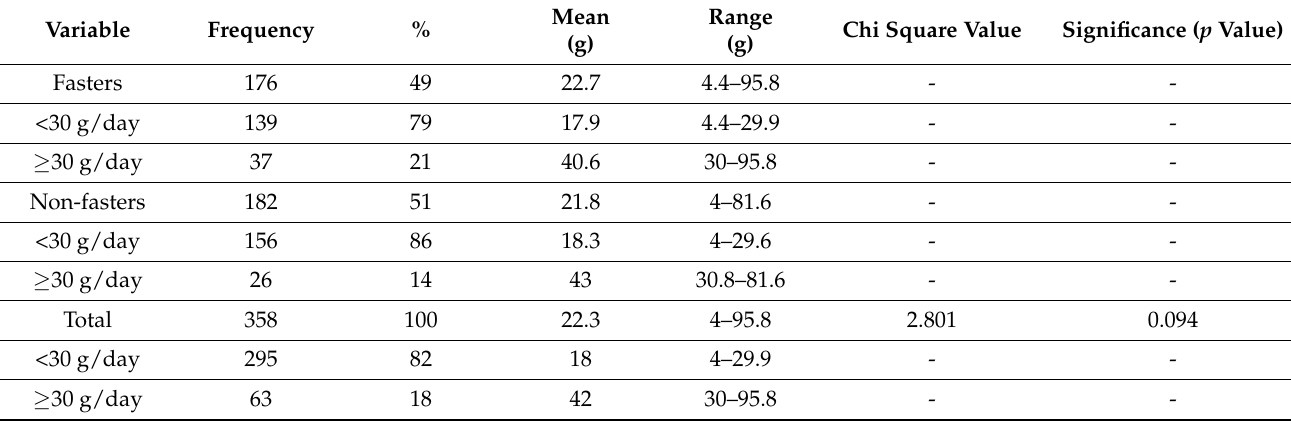
Table 2. Dietary fibre